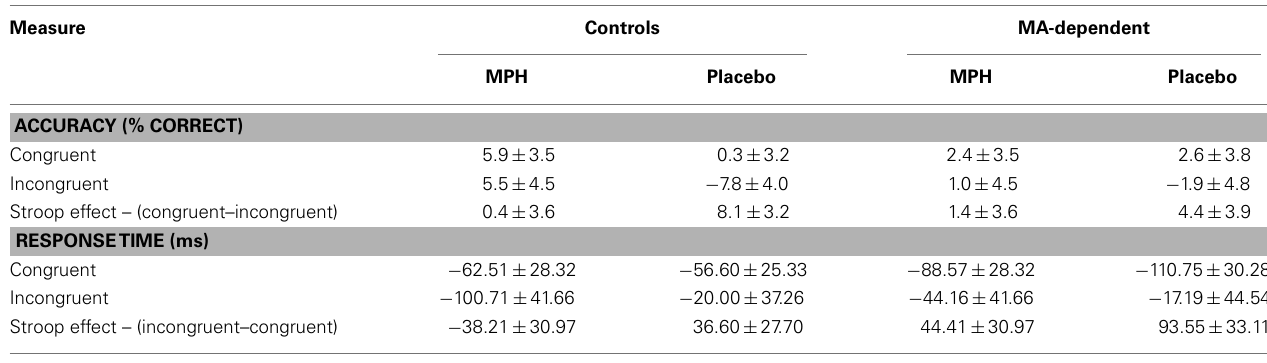
Table 3 | Mean ± standard error for post-drug minus pre-drug measures of accuracy and response time during performance of the color-word Stroop task (group–drug